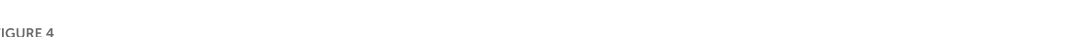
FIGURE4 Daba-Wushan Mountains, (8) Wuling Mountain, (9) the border areas of Yunnan, (10) the border areas of Guangxi, (11) the boundary areas of Guizhou and Guangxi, (12) Dayao Mountain, (13) southern part of Xuefeng Mountain, (14) western part of Nanling Mountain, (15) eastern part of Nanling Mountain, (16) Luoxiao Mountain, (17) Mufu-Lianyun- Jiuling Mountains, (18) Dabie Mountain, (19) Huangshan-Tianmu Mountains, (20) Wuyi Moutain, (21) Taiwan Island, (22) southern part of Hainan